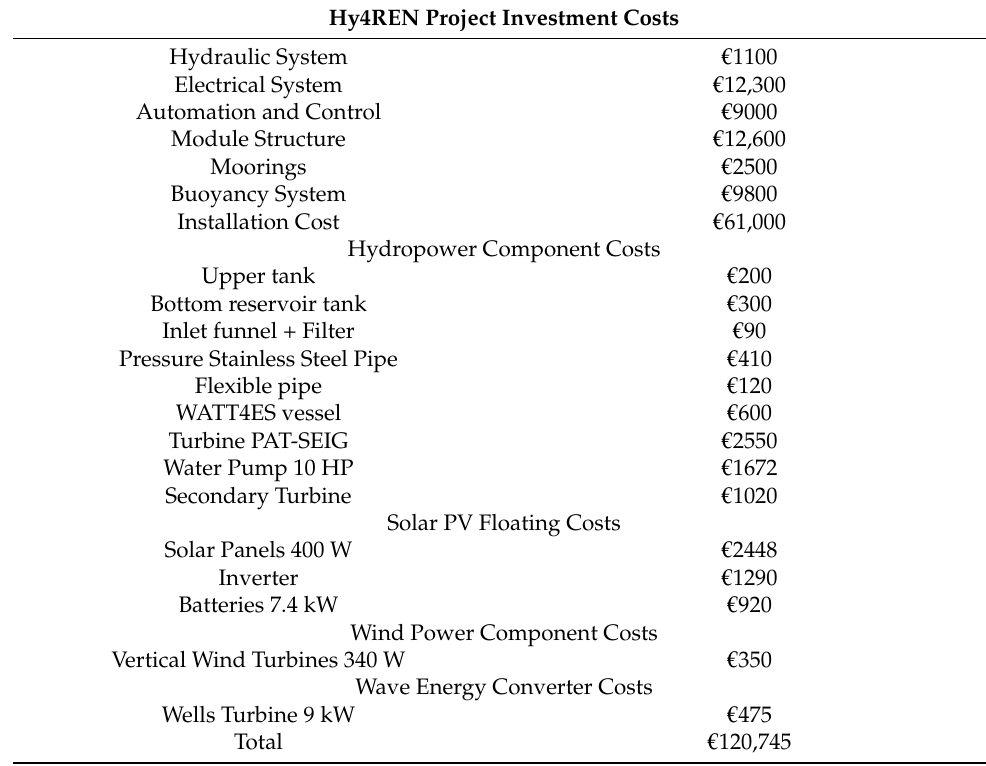
Table 10. Hy4REN total investment cost.